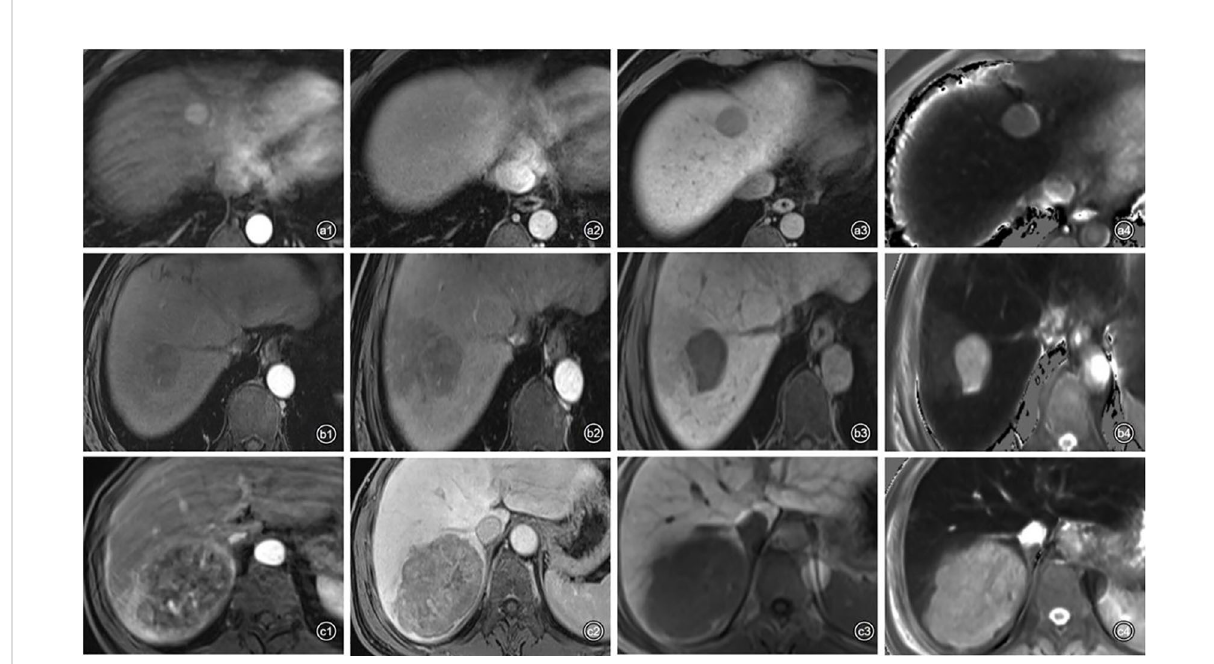
FIGURE 6 Representative images of each phase on Gd-EOB-DTPA-enhanced MRI and T1 mapping 20 min after enhancement in patients with high or low Ki-67 expression. a1 – 4: A 48-year-old man with Edmondson – Steiner grade II HCC and low expression of Ki-67 (10%). (a1) APHE; (a2), washout and complete capsule; (a3), smooth tumor margin; (a4), T1rt-20 min = 509.92 ms. b1 – 4: A 58-year-old man with Edmondson – Steiner grade III HCC and high expression of Ki-67 (30%). (b1) no APHE; (b2), peritumoral enhancement; (b3), peritumoral hypointensity and non-smooth tumor margin; (b4), T1rt-20 min = 1,062.86 ms. c1 – 4: A 59-year-old man with Edmondson – Steiner grade II HCC and high expression of Ki-67 (40%). (c1), rim enhancement and peritumoral enhancement; (c2), washout; (c3), non-smooth tumor margin; (c4), T1rt-20min = 971.84 ms.